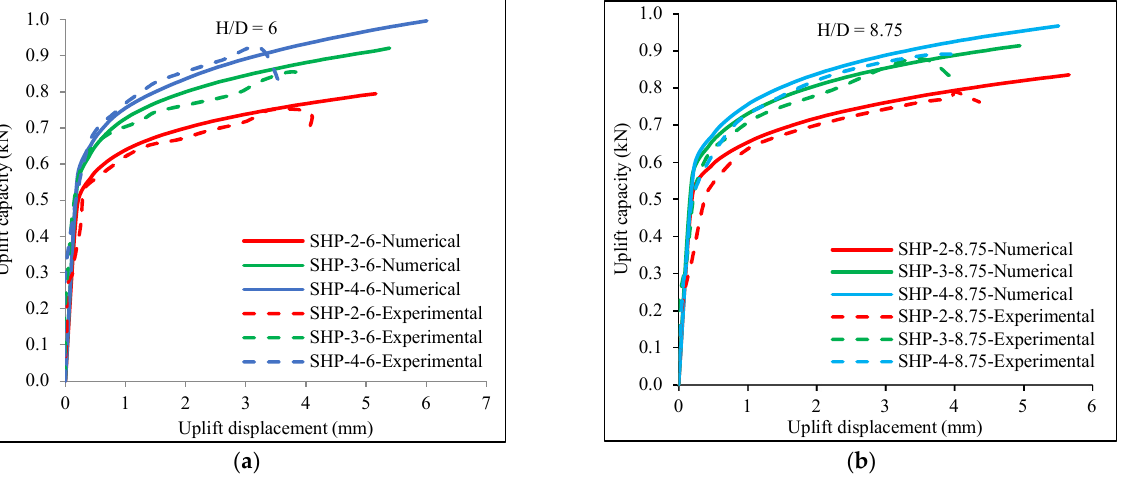
Figure 11. Comparison between Experimental and Numerical results—Uplift loading, ( a ) H/D = 6; and ( b ) H/D = 8.75.